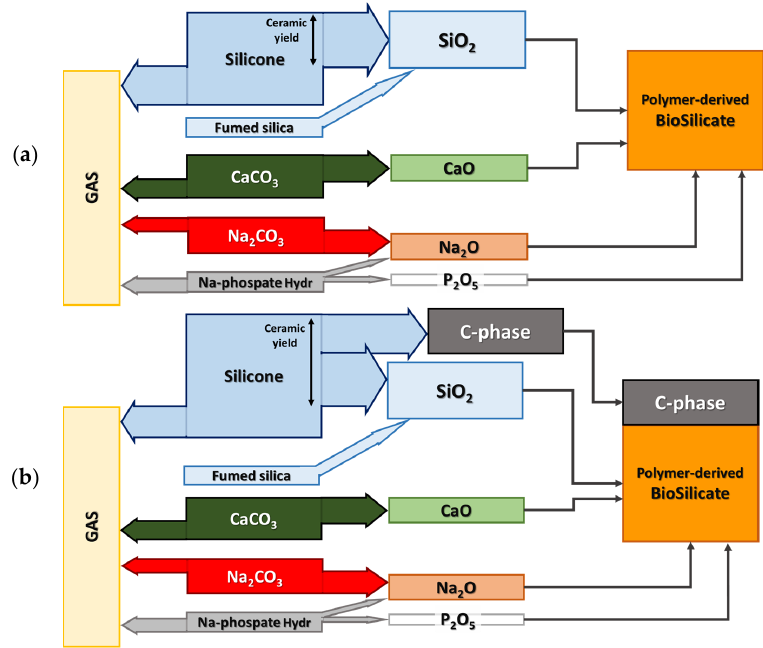
Figure 2. Scheme for the formulation of silicone-based inks aimed at transformation into: ( a ) poly- mer-derived Biosilicate ® -like ceramic; ( b ) polymer-derived Biosilicate ® -like ceramic/C composite.